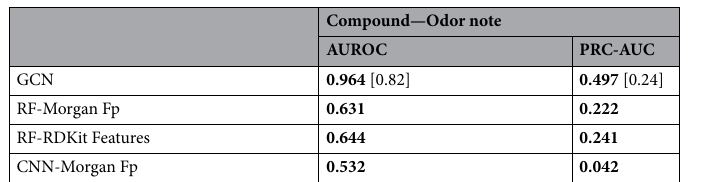
Table 3. Performance of the 4 models applied on the compound-odor note dataset. The results in bold are the performance on the full dataset. The value in brackets depicts the results of the fivefold cross validation model.